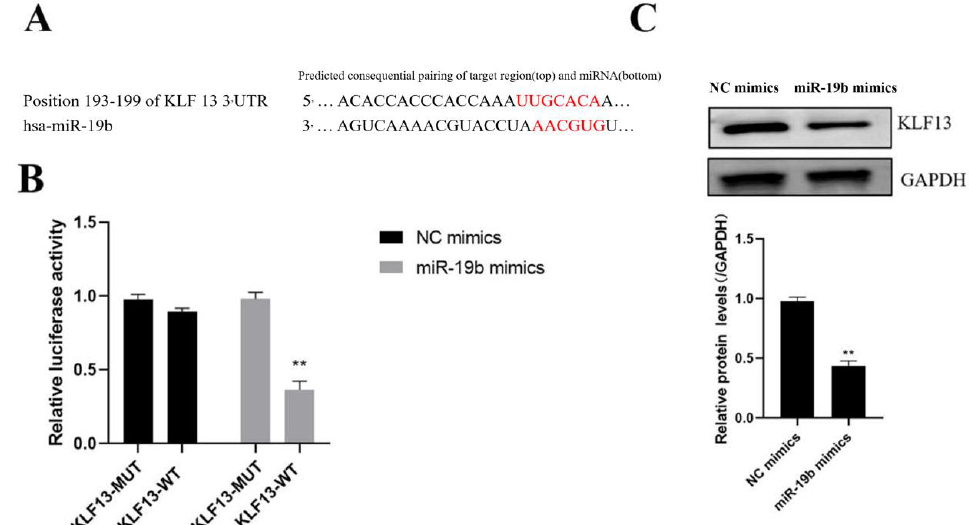
Figure 3. miR-19b targets KLF13 expression. ( A ) Bioinformatics website analysis of the binding site of KLF13 3 ’ -UTR to miR-19b, ( B ) dual luciferase reporter gene to identify miR-19b and KLF13 bind- ing, ( C ) Western blot analysis of several transfections protein expression of post-KLF13. Compared with NC mimics group. ** p < 0.01.